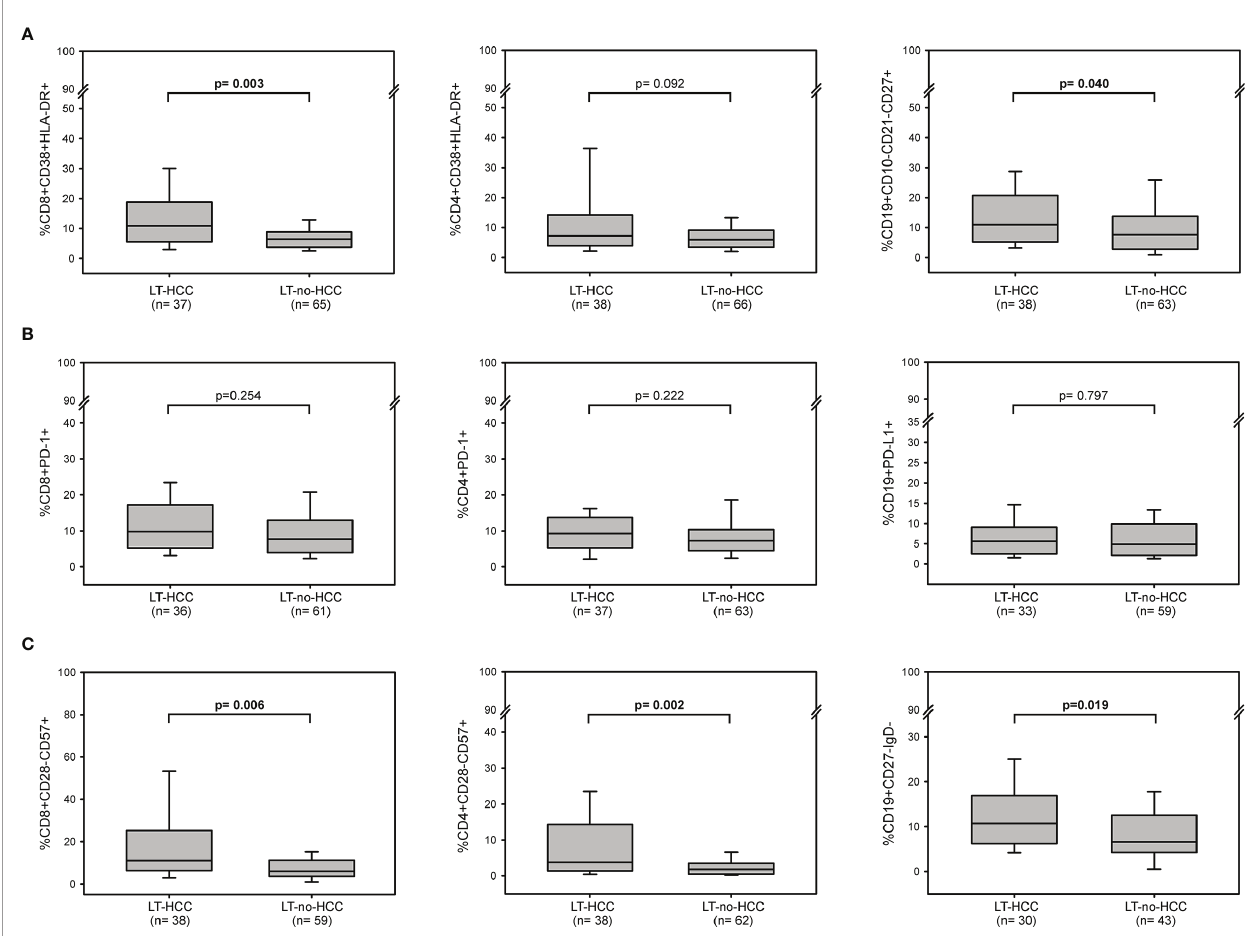
FIGURE 1 | Baseline immune activation, exhaustion and senescence pro fi les in LT-HCC and LT-no-HCC patients. Percentages of (A) activated CD8 + (CD3 + CD8 + CD38 + HLA-DR + ), CD4 + (CD3 + CD4 + CD38 + HLA-DR + ) and memory B (CD19 + CD10 - CD21 - CD27 + ) cells; (B) exhausted CD8 + (CD3 + CD8 + PD-1 + ), CD4 + (CD3 + CD4 + PD-1 + ) and B (CD19 + PD-L1 + ) cells, (C) senescent-like CD8 + (CD3 + CD8 + CD28 - CD57 + ), CD4 + (CD3 + CD4 + CD28 - CD57 + ), and B (CD19 + CD27 - IgD - ) cells in LT-HCC and LT-no-HCC patients. All p-values were adjusted by